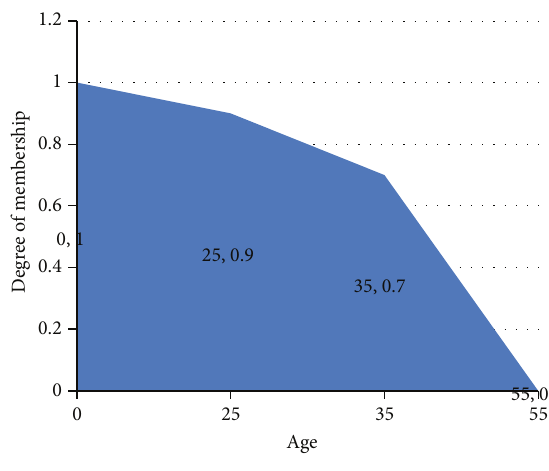
Figure 1: The plot of the